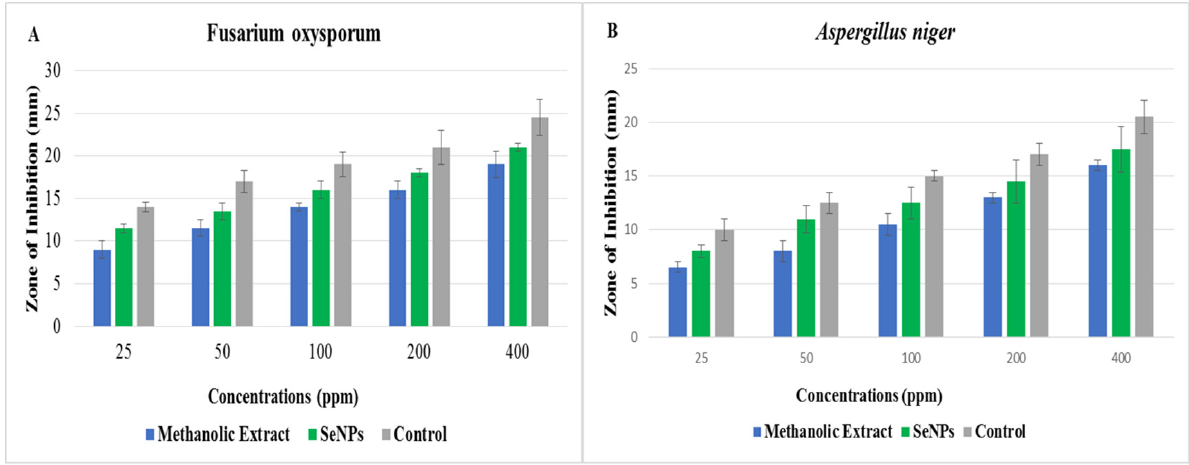
Figure 4. ( A ) Zone of inhibition against F. oxysporum and ( B ) Zoneof inhibition against A. niger .